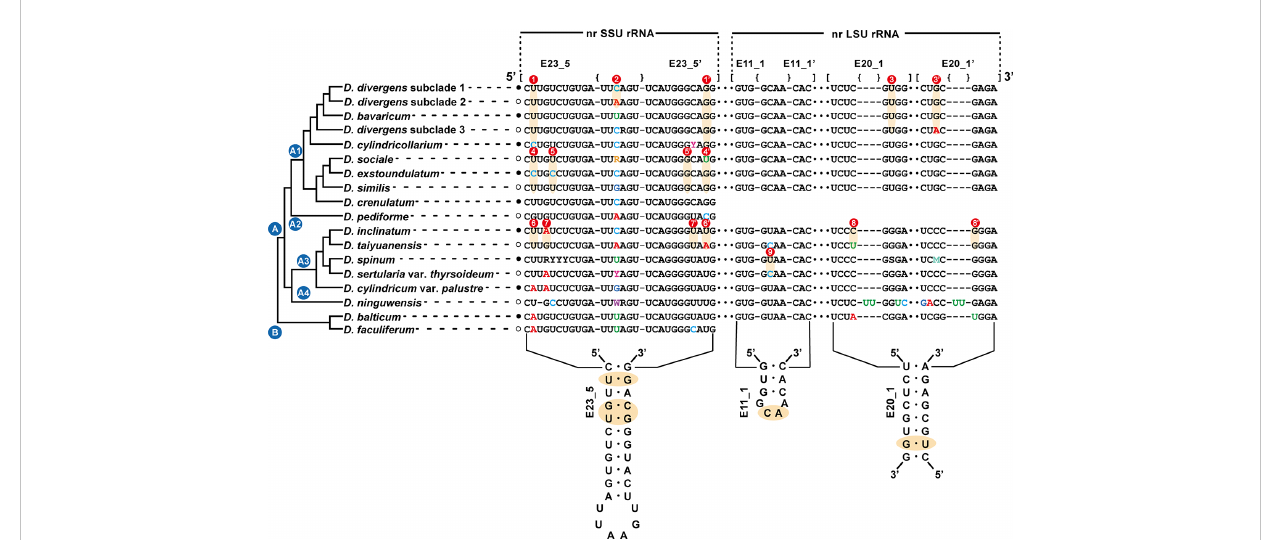
FIGURE 3 Molecular signatures of the E23-5 helix of the V4 region in the nuclear SSU rRNA, the E11-1 helix of the D7b region and the E20-1 helix of the D8 region in the nuclear LSU rRNA differentiating the Dinobryon species. The secondary structure was constructed based on the rRNA molecules of D. divergens CCMP2900. The nr LSU rRNA sequence data of D. crenulatum and D. pediforme was not available. The nomenclature of nucleotides and base pairs depends on the polarity of the DNA: increasing numbers generally indicate the 5 ’ to 3 ’ direction. [] indicates the beginning and end of the stem, with {} indicating nonbinding (loops, bulges) of the base